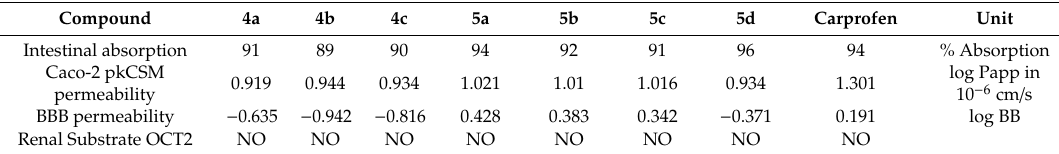
Table 6. Prediction of intestinal absorption, permeability of Caco2, blood–brain barrier (BBB) permeability, Renal